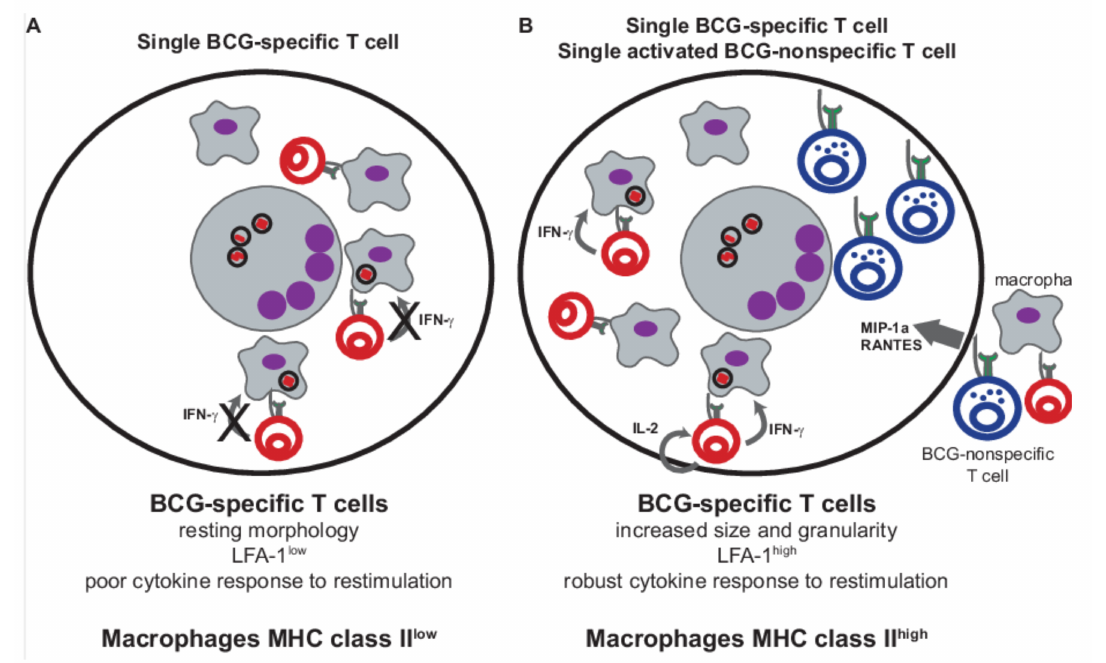
Figure 7. The effect of BCG-non-specific T cells on the function of BCG-specific T cells and BCG-induced granulomas. ( A ), BCG granulomas in a BCG-specific, monoclonal T cell granuloma control BCG infection despite anergic T cells with a nonactivated phenotype and poor cytokine secretion as well as low levels of macrophage activation. ( B ), An activated, BCG-non-specific T cell is able to accumulate in the granuloma and rescue the anergic BCG-specific T cells, resulting in the BCG-specific T cells acquiring an activated phenotype, increasing cytokine secretion and activating